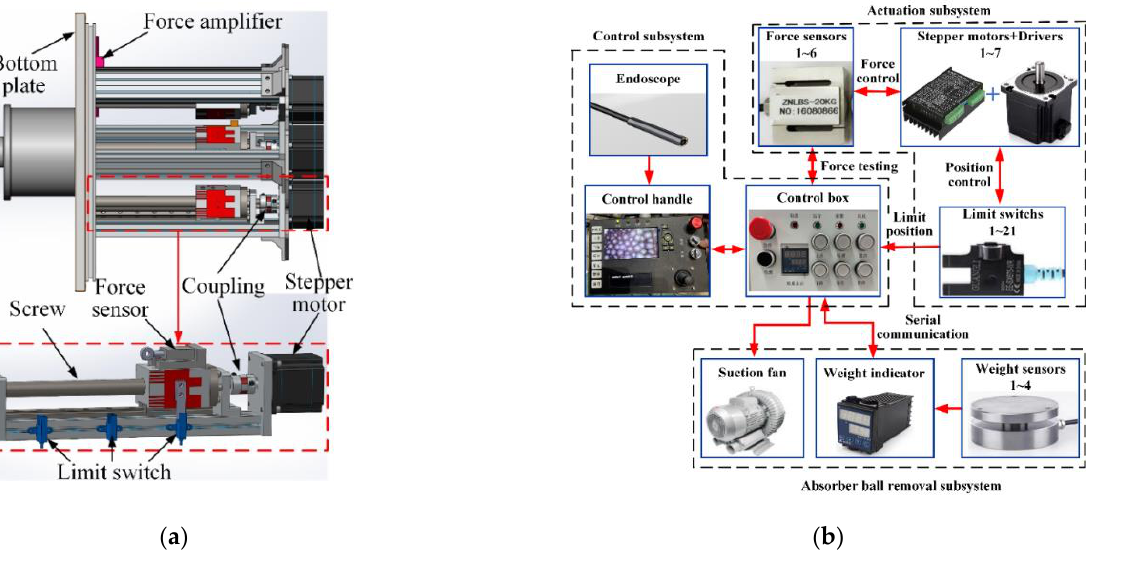
Figure 10. The actuation and control system. ( a ) Structure and composition of the actuation box. ( b ) Block diagram of the control system.